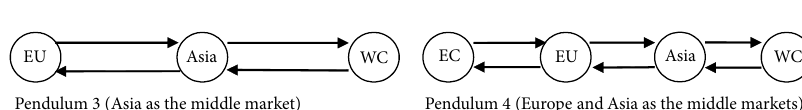
Table 1. Information of a shipping service (CI